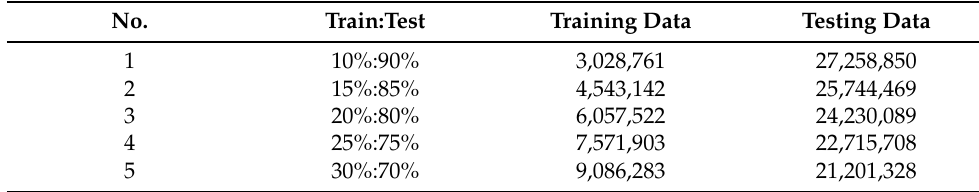
Table 2. QoS data